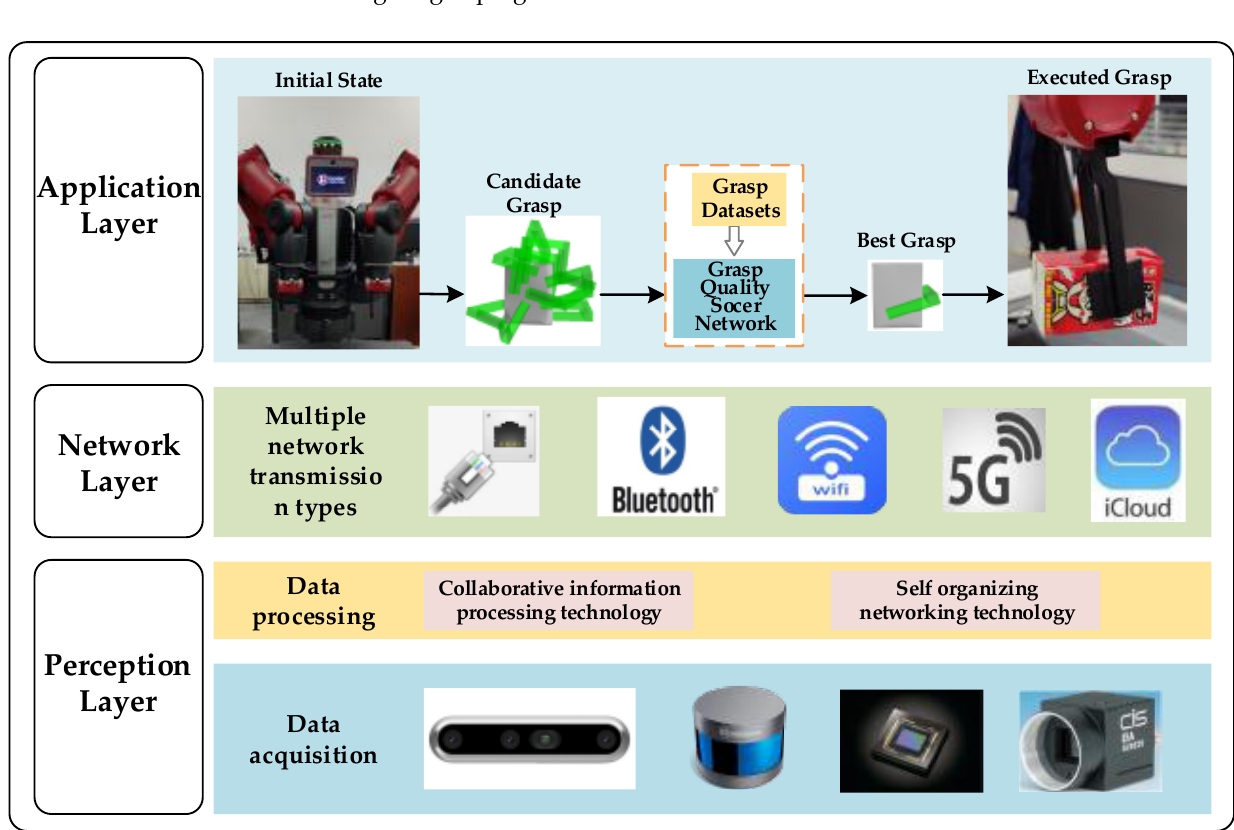
Figure 1. IoT architecture — Intelligent robot point cloud grasping.